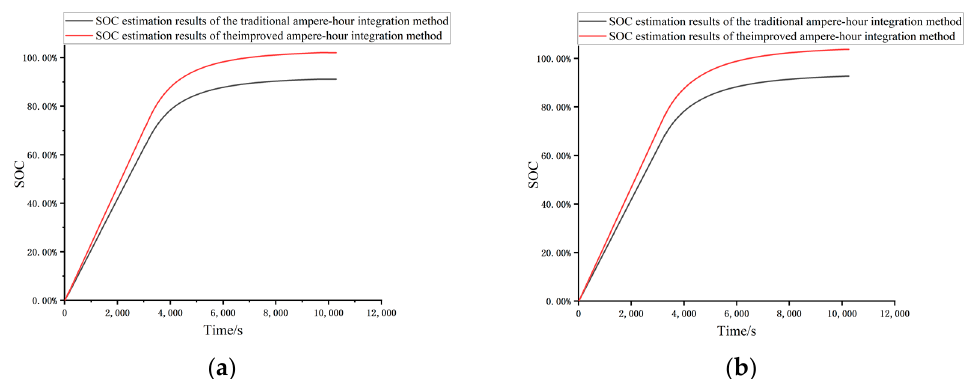
Figure 10. SOC estimation curve under the 20th cycle of the No.5 and No.25 batteries. ( a ) SOC estimation for the 20th charge cycle of No.5 battery. ( b ) SOC estimation for the 20th charge cycle of No.25 battery.